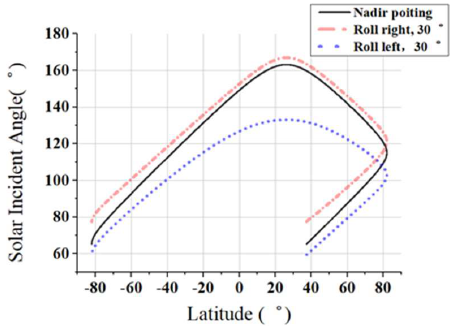
Figure 11. The angle between solar vector and camera axis.